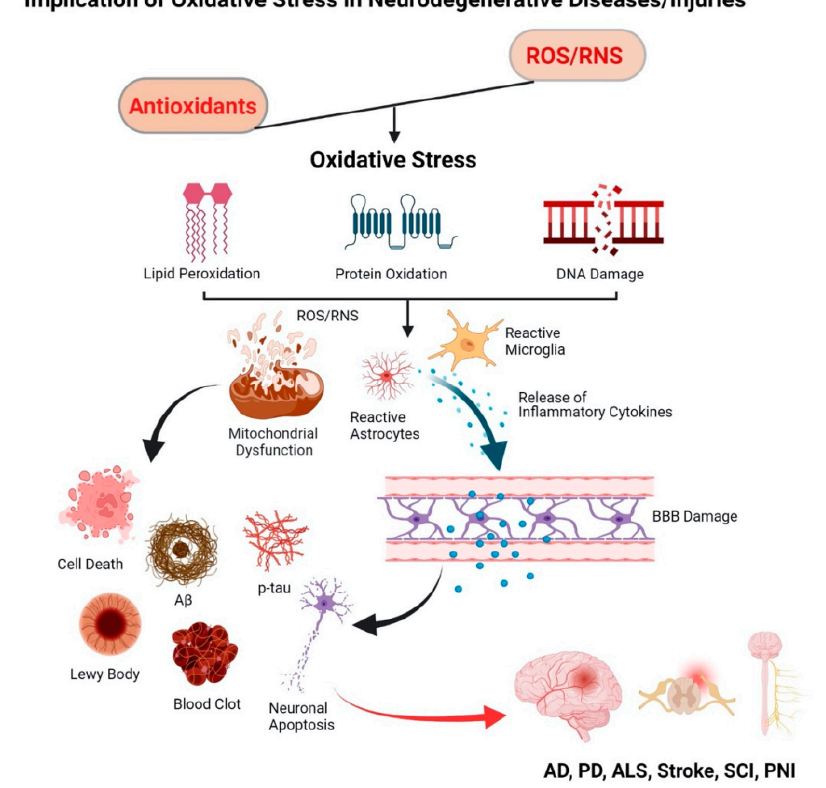
Figure 1. Schematic representing the effect of oxidative stress in neurodegenerative diseases. Im- balance in the level of ROS/RNS and antioxidants leads to an oxidative stress condition that causes damage to cellular biomolecules, i.e., lipids, proteins, and DNA. Mitochondrial dysfunction and accumulation of activated astrocytes and microglia release inflammatory cytokines and chemokines, promoting cellular apoptosis and tissue